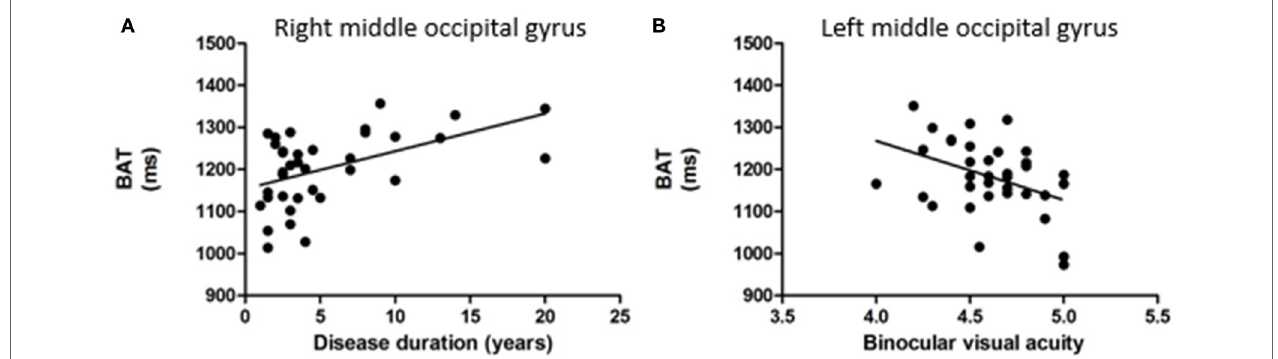
FigUre 4 | (a) Correlation analysis results between bolus arrival time (BAT) in the right middle occipital gyrus and the disease duration. (B) Correlation analysis results between BAT in the left middle occipital gyrus and the binocular visual